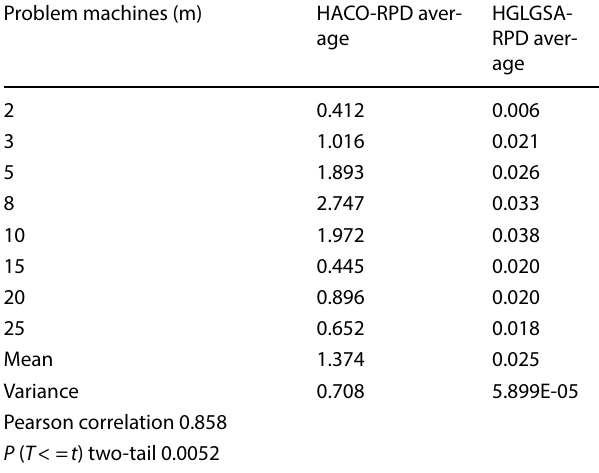
Table 4 The results of the t -test for proposed HGLGSA and HACO